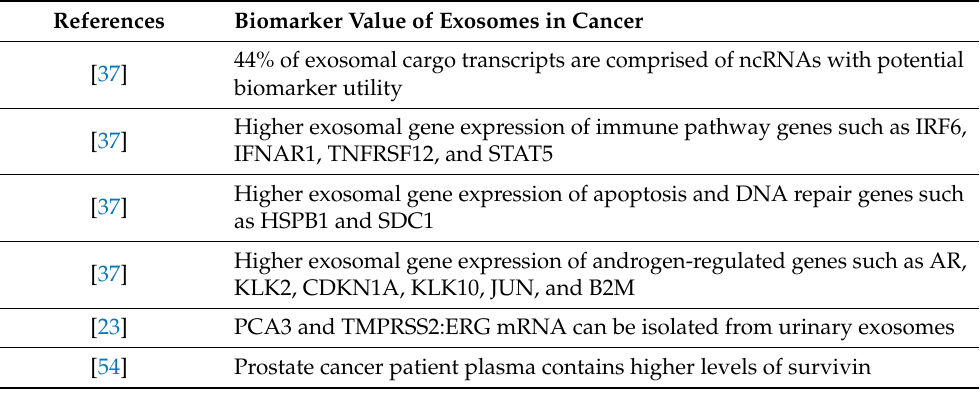
Table 2. Summary of the biomarker value of exosomes in